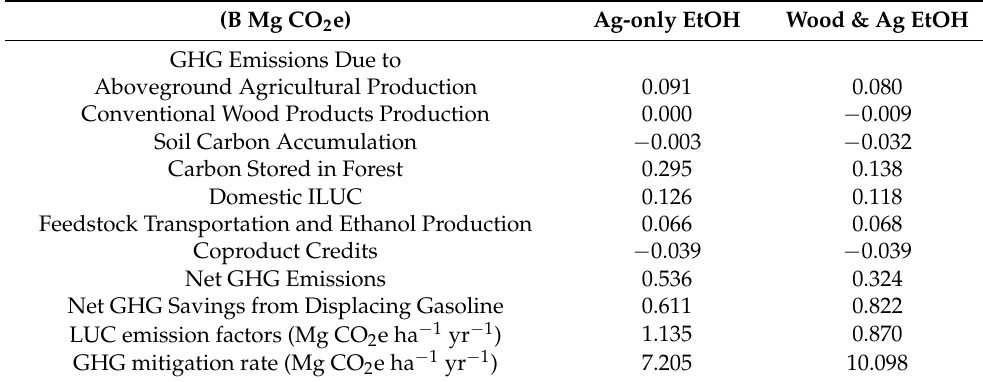
Table 1. Cumulative GHG emissions and GHG savings due to cellulosic ethanol